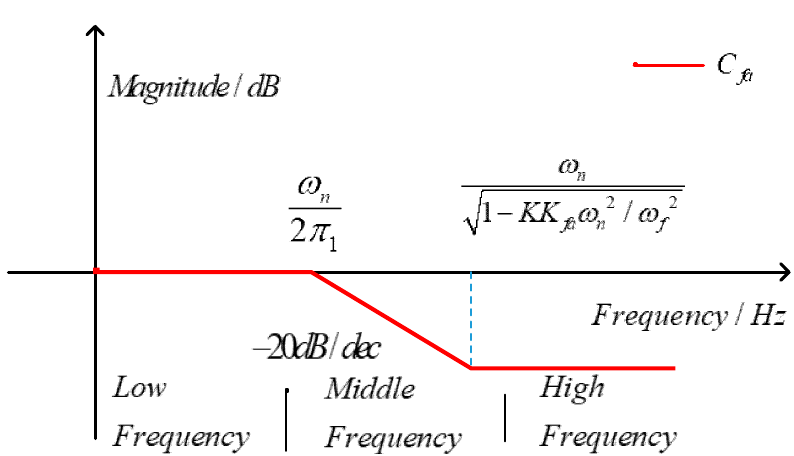
Figure 5. Bode diagram of original lead-lag disturbance compensator.